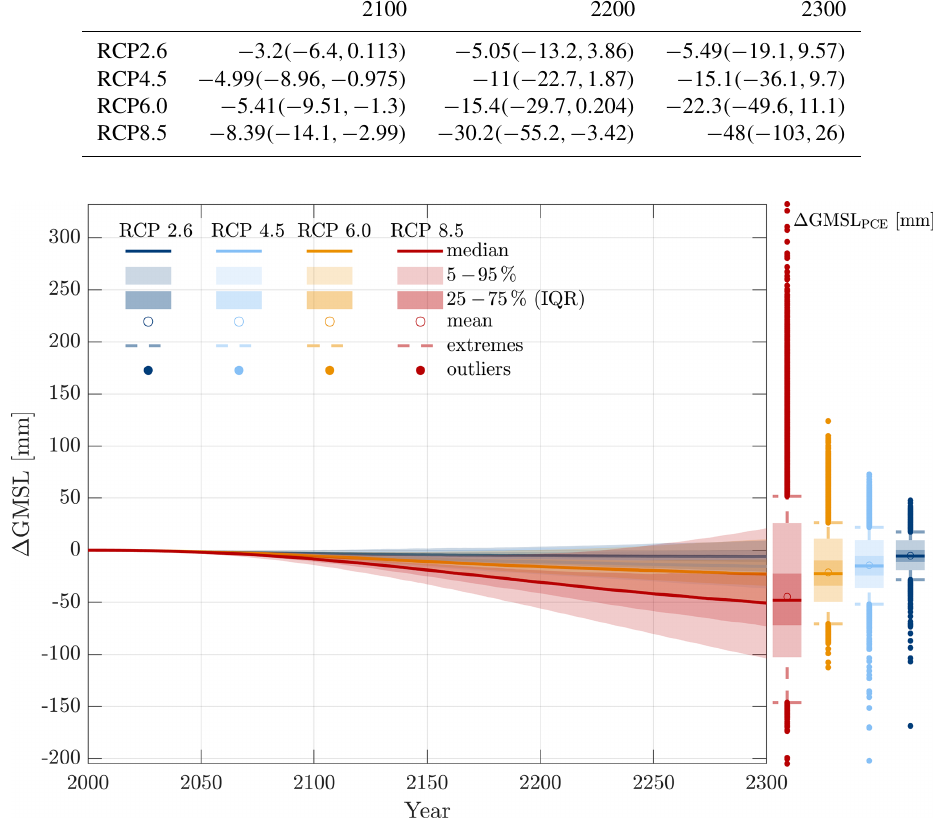
Table 1. Contribution to global mean sea level (mm) at the years 2100, 2200, and 2300. The first number is the median projection, and values in brackets are 5%–95% confidence intervals